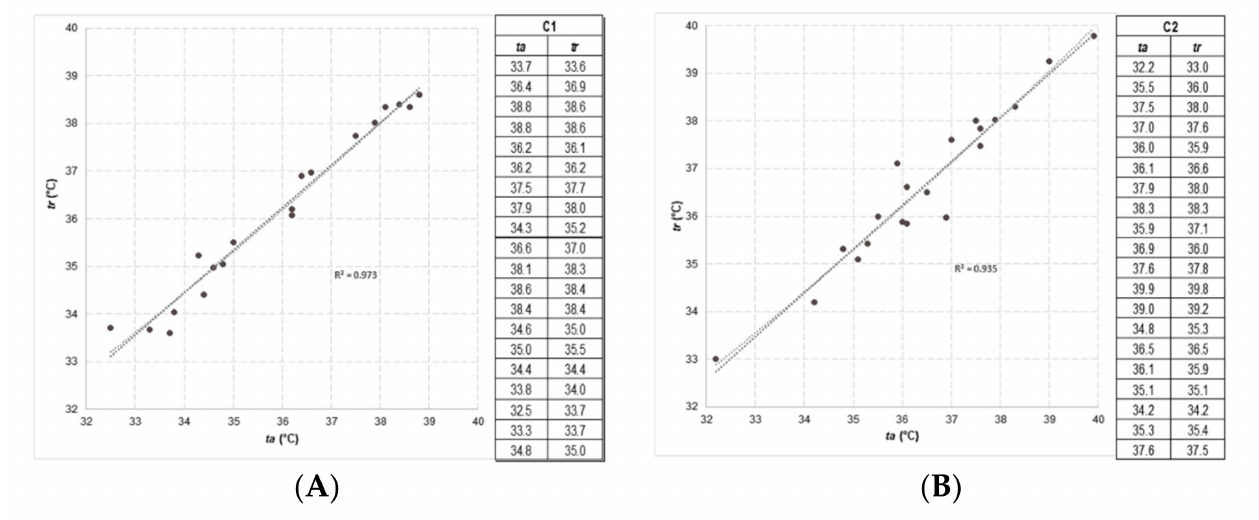
Figure 7. Radiant temperature ( tr ) and dry bulb temperature (Tbs): ( A ) Cell C1; ( B ) Cell C2.